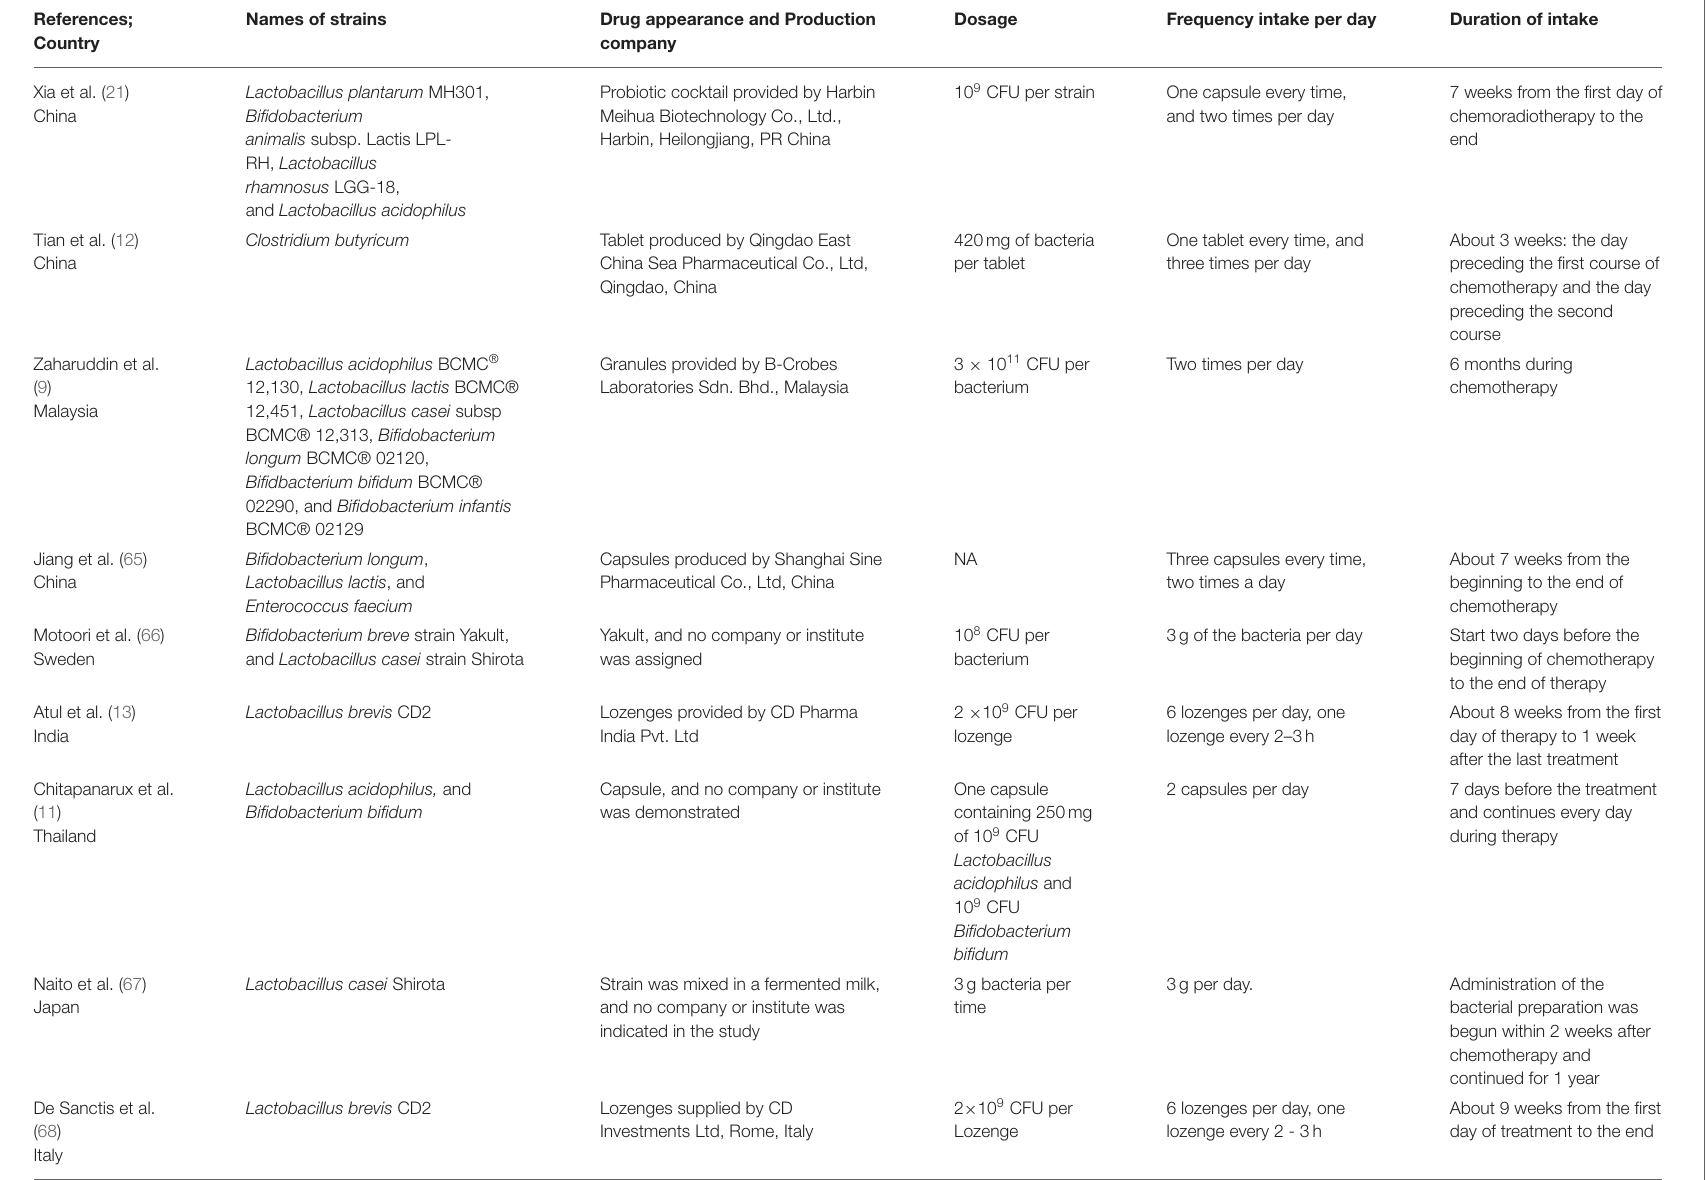
TABLE 2 | Characteristics of the probiotics in the 12